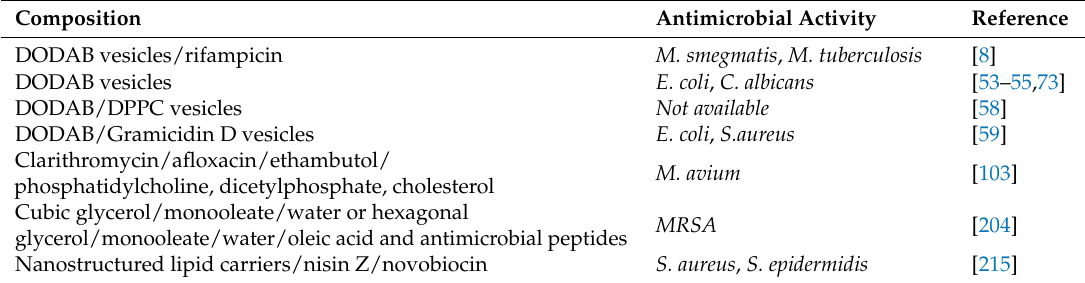
Table 3. Self-assembled lipid-based nanomaterials: composition and antimicrobial activity.